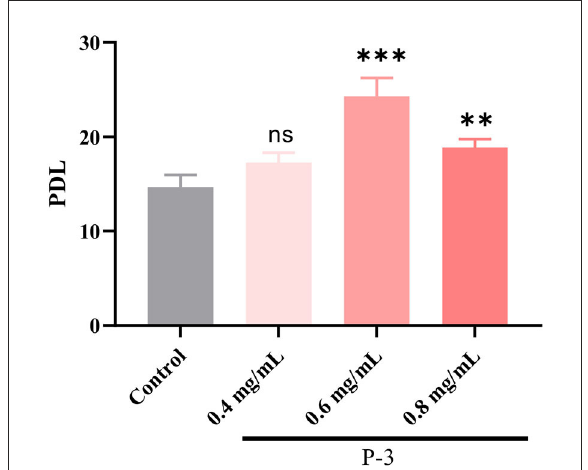
FIGURE4 PDL of the 1.4mM H 2 O 2 -induced HSF cells after treatment with 0.4, 0.6, and 0.8 mg/ml of P-3 for 24h, respectively. Control was treated with 1.4mM H 2 O 2 for 1h. ** and *** indicate the differences in the p -value of < 0.05 and p -value of < 0.001, respectively.